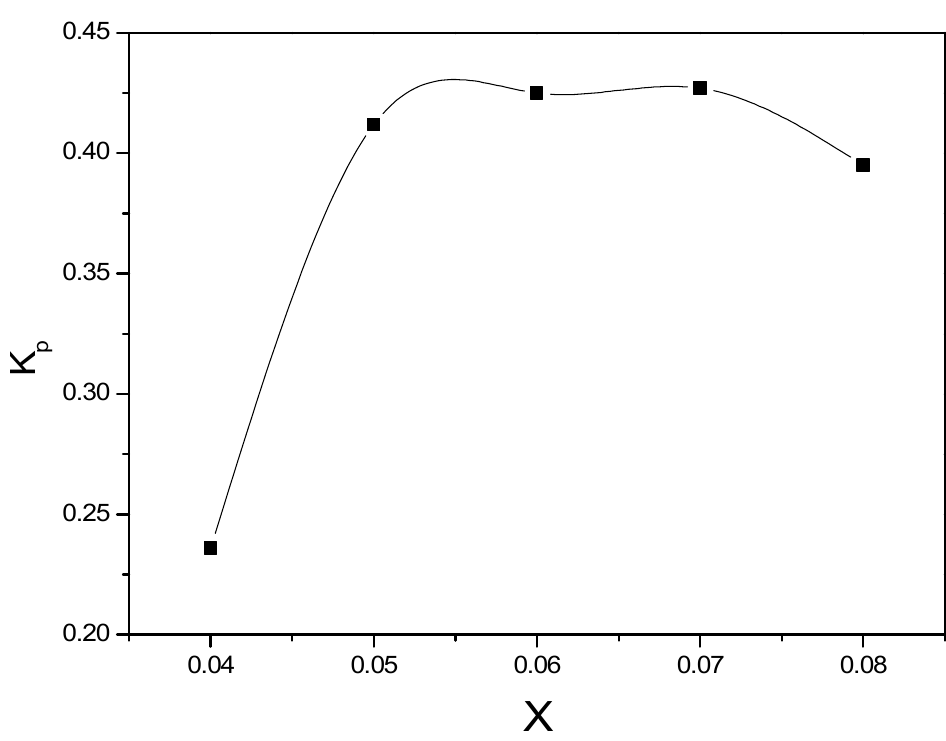
Figure 5. Electromechanical coupling factor (k p ) of samples with the amount of antimony.